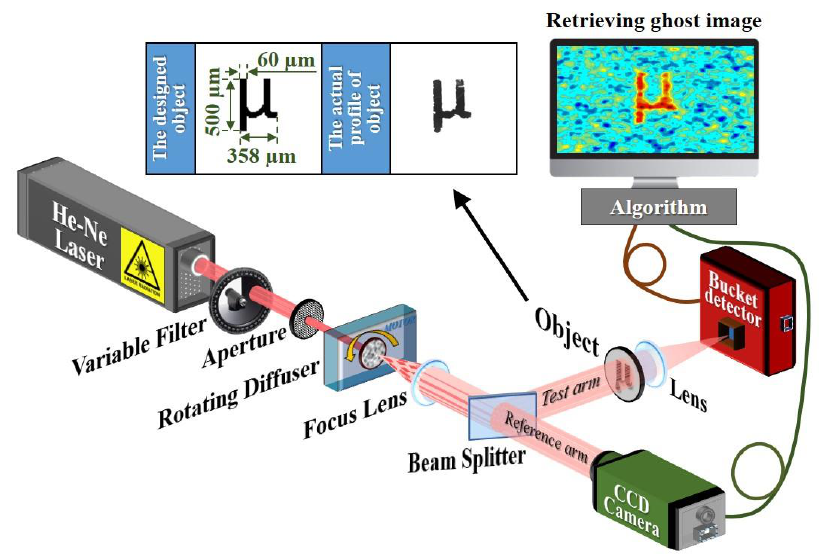
Figure 1. Schematic of the microscale pseudothermal ghost imaging experimental setup and the used object. Because of the laser-cutting fabrication process, the object size is certified by conventional microscopy.